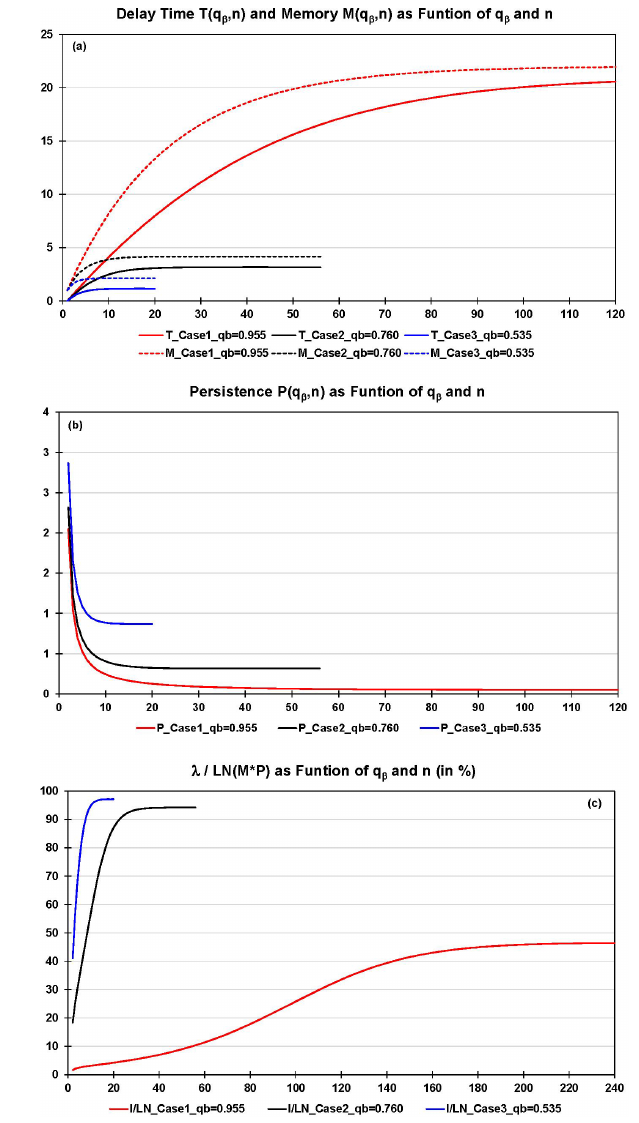
Figure 7. Cases 1–3: (a) delay time T and memory M (in units of 1), (b) persistence P (in units of 1), and (c) the ratio λ/ ln( M · P ) (in %); all are versus time (in units of 1) as of n = 0 (1959).